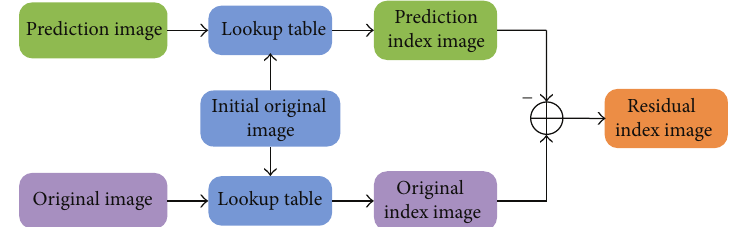
Figure 4: The Structure of the simplified depth coding algorithm.